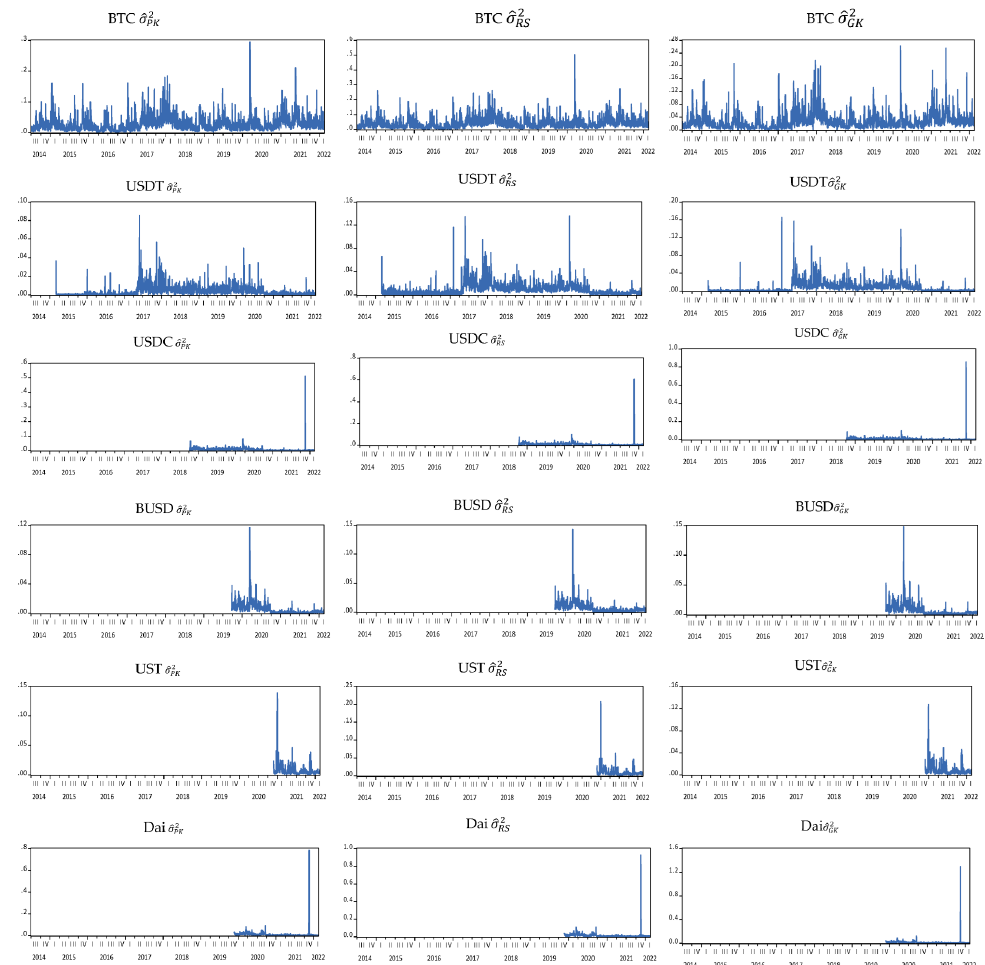
Figure 1. Results for range-based volatility estimators among Bitcoin and stablecoins markets. Note: The ticker is denoted for Bitcoin (BTC), Tether (USDT), USD Coin (USDC), Binance USD (BUSD), Terra USD (UST), and Dai